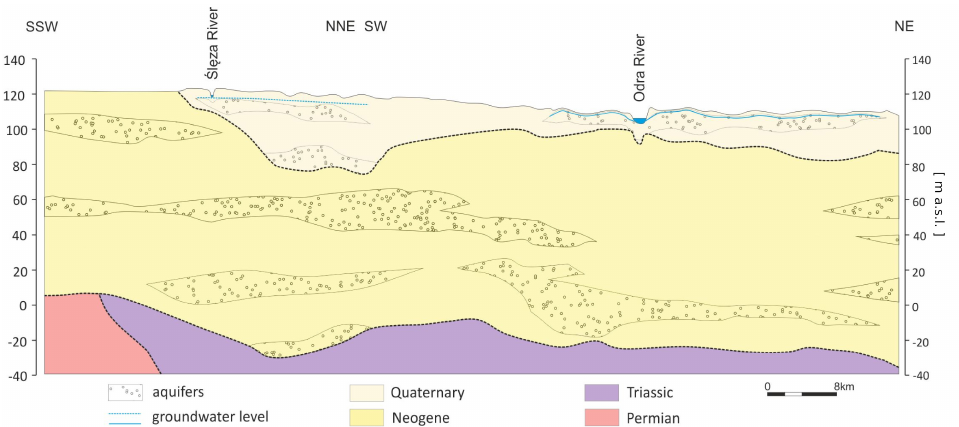
Figure 2. Conceptual cross-section through the city of Wrocław with elements of hydrogeology